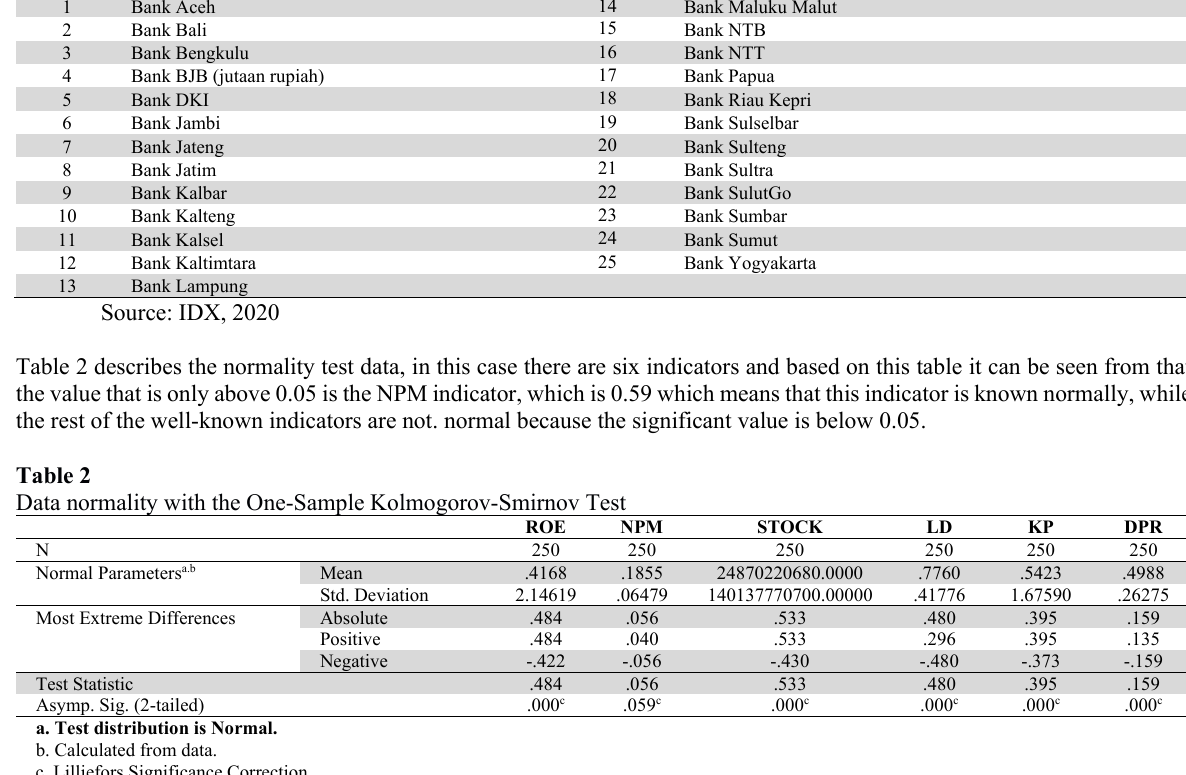
Regional Development Banks (BPD) No